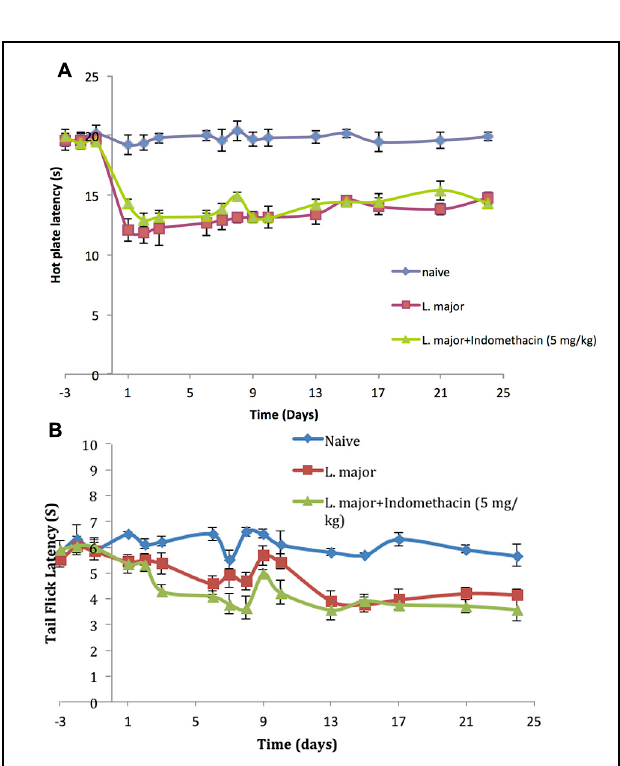
FIGURE 3 | The time course of the effect of the daily intraperitoneal (i.p.) injection of indomethacin on L. major (high dose) induced hyperalgesia: as assessed by (A) the Hot Plate (HP) Test and (B) the Tail Flick (TF) Test. Mice were injected with 4 × 10 6 promastigotes per 50 μ l per left hind paw and another group also with 5.0 mg/kg of indomethacin for 7 consecutive days. Each result is the mean of 5 mice ± SEM and the degree of significance was calculated with reference to indomethacin non-treated